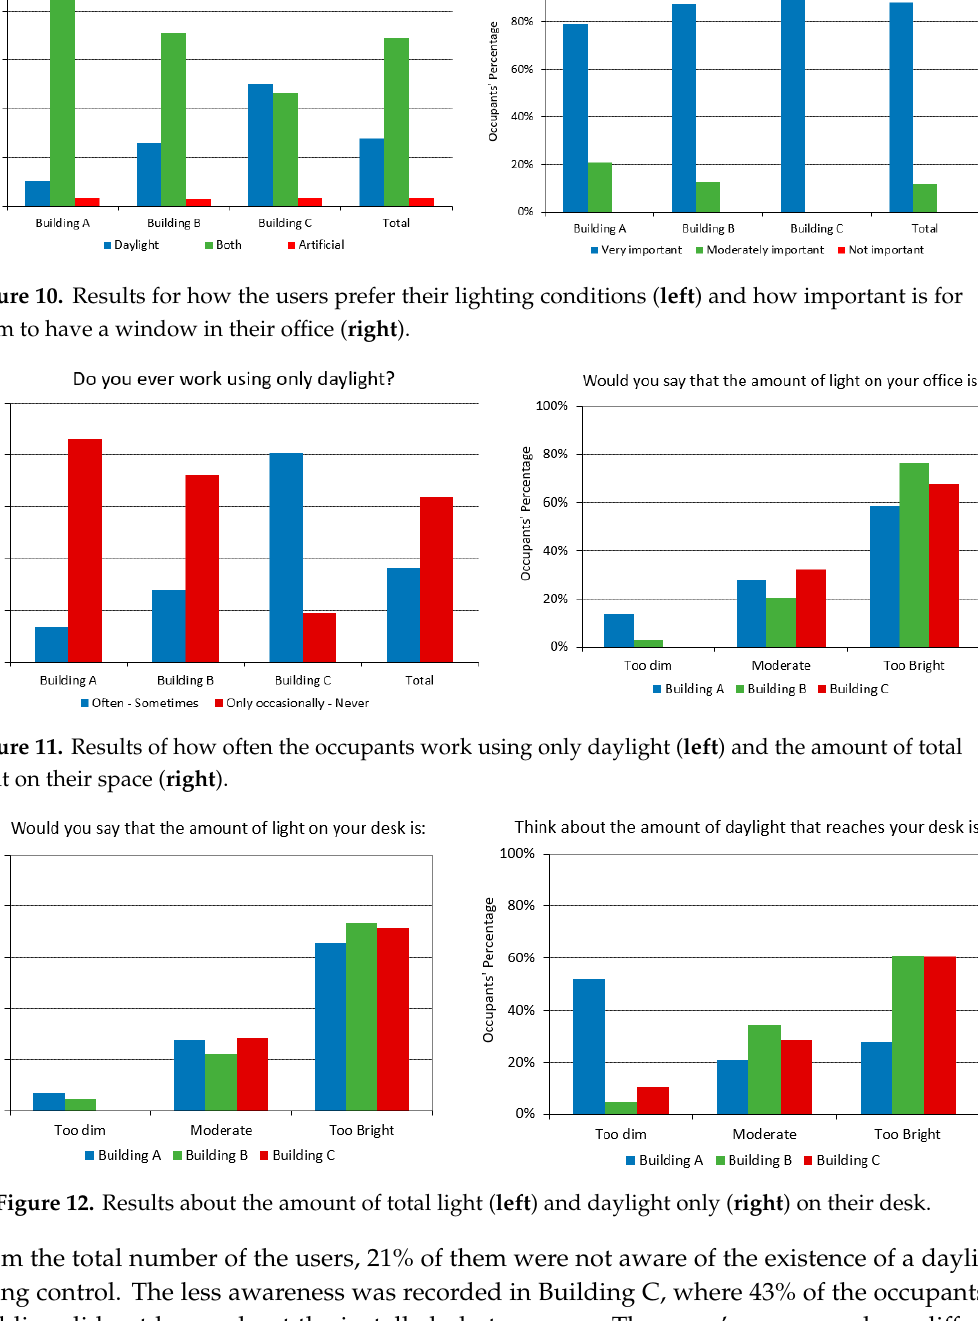
Figure 12. Results about the amount of total light ( left ) and daylight only ( right ) on their